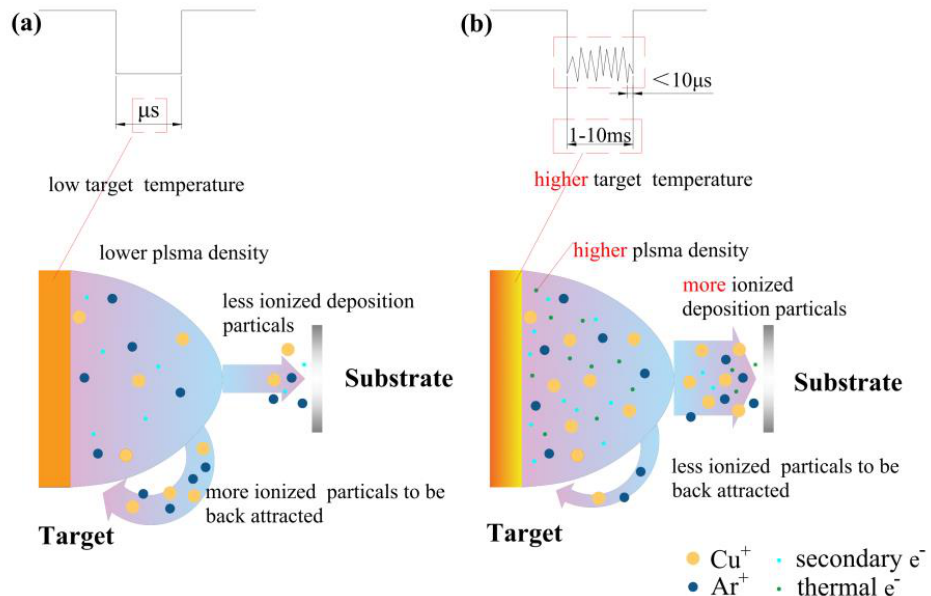
Figure 4. Schematics of the discharge mechanism: ( a ) conventional HiPIMS and ( b ) oscillating pulse magnetron sputtering (OPMS).